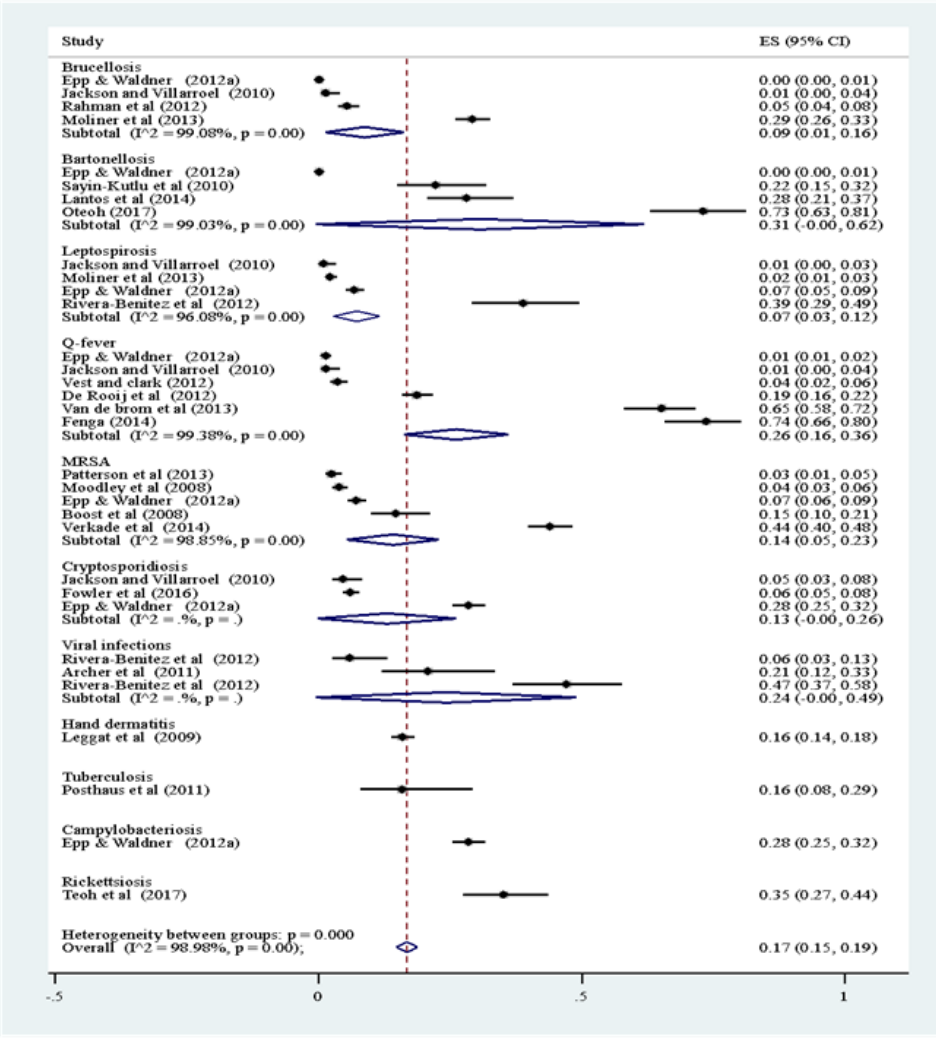
Figure 3 Forest plot of pooled prevalence of biological hazards among veterinarians